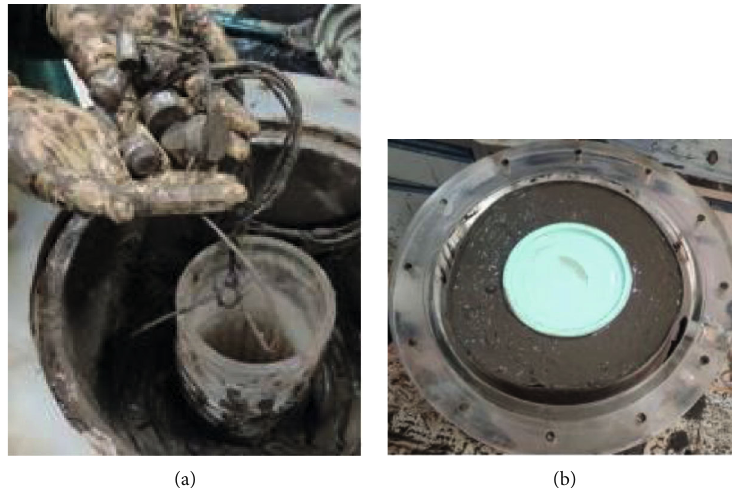
Figure 8: (a) The photograph of strain sensor; (b) the photograph of seepage Table 3: Volume fraction of tailing sand under di ff erent head di ff erences.